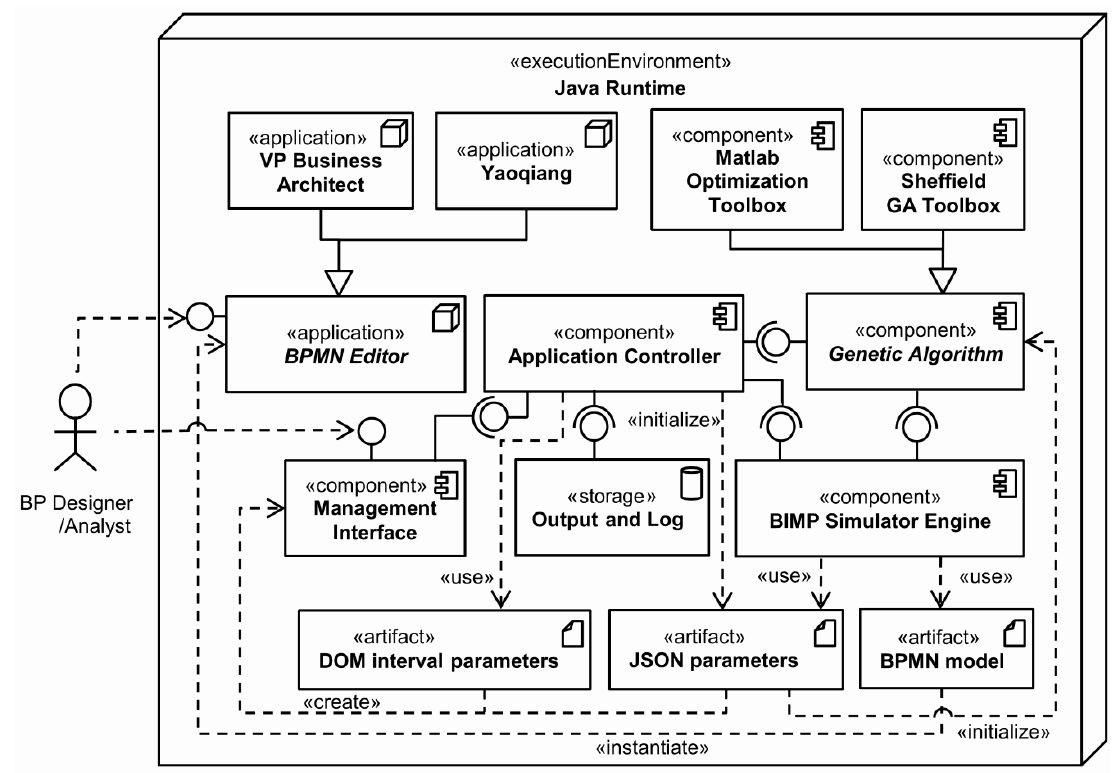
Figure 10. IBimp, overall system